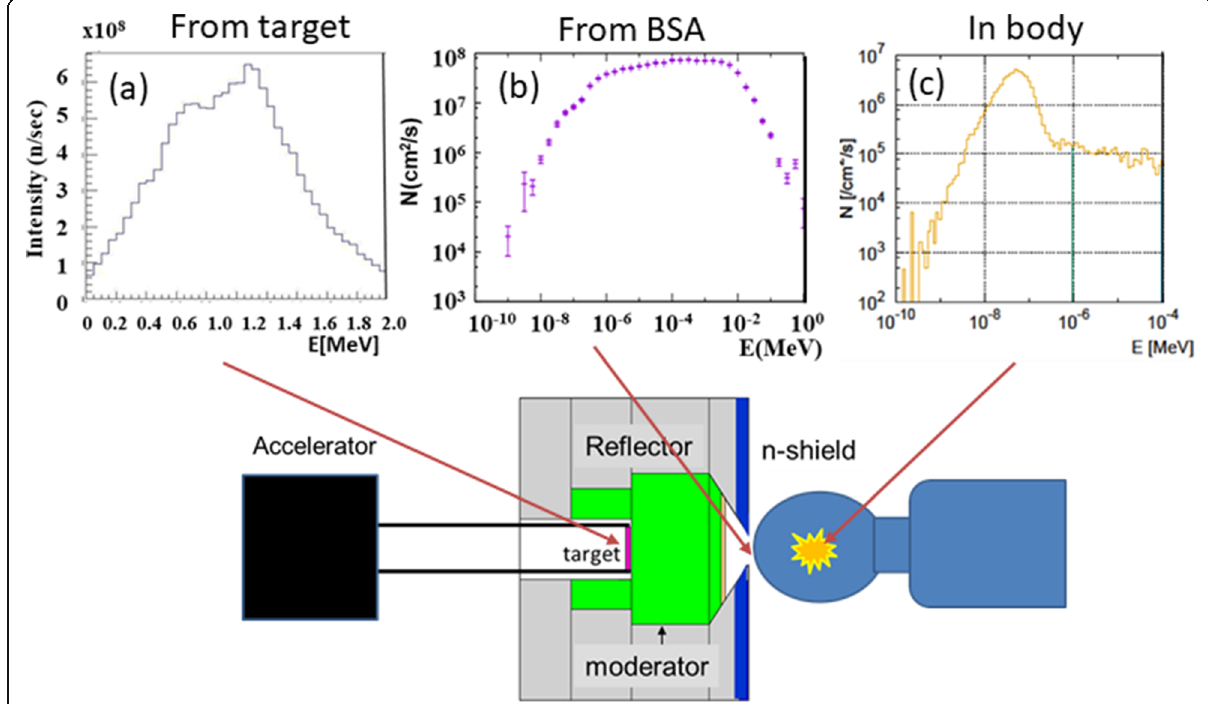
Fig. 20 Energy spectrum variation from the target to the human